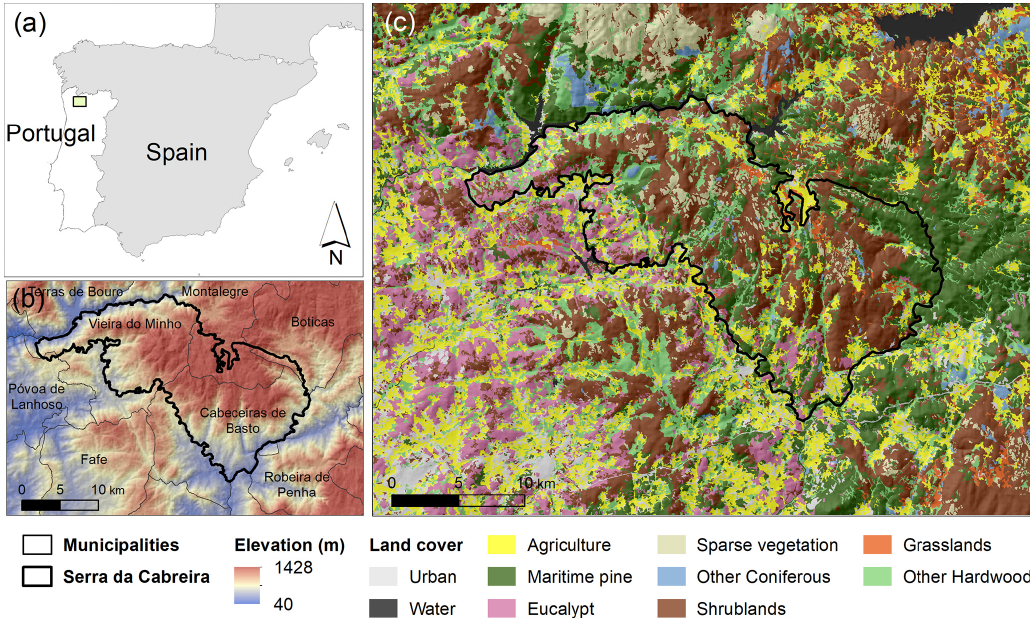
Figure 1. (a) Study area centered in Serra da Cabreira and its relative position to the Iberian Peninsula, (b) elevation and Portuguese municipalities, and (c) main land use–land cover classes.